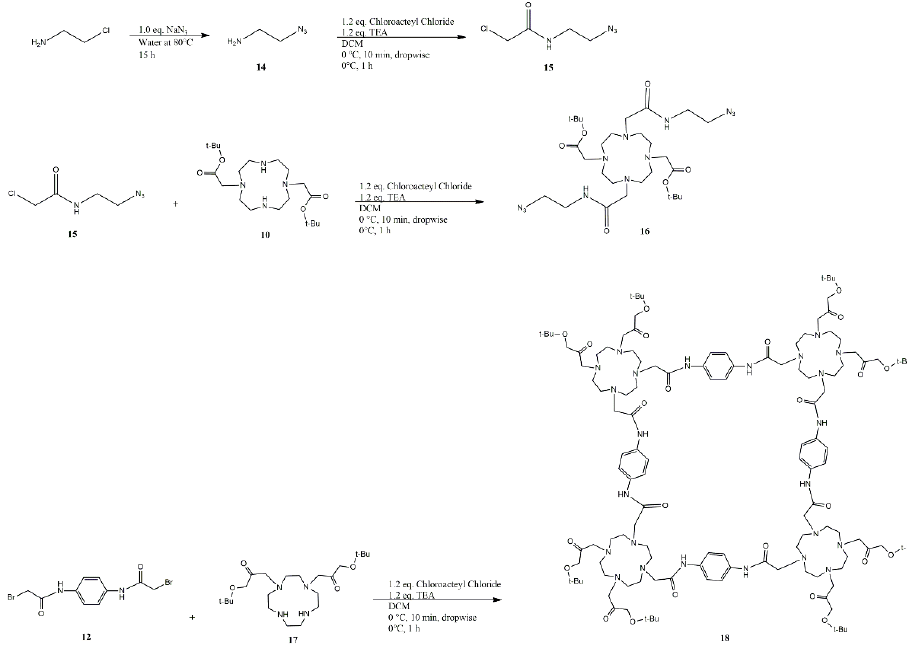
Figure 5. Synthetic pathway for molecules 14–18.